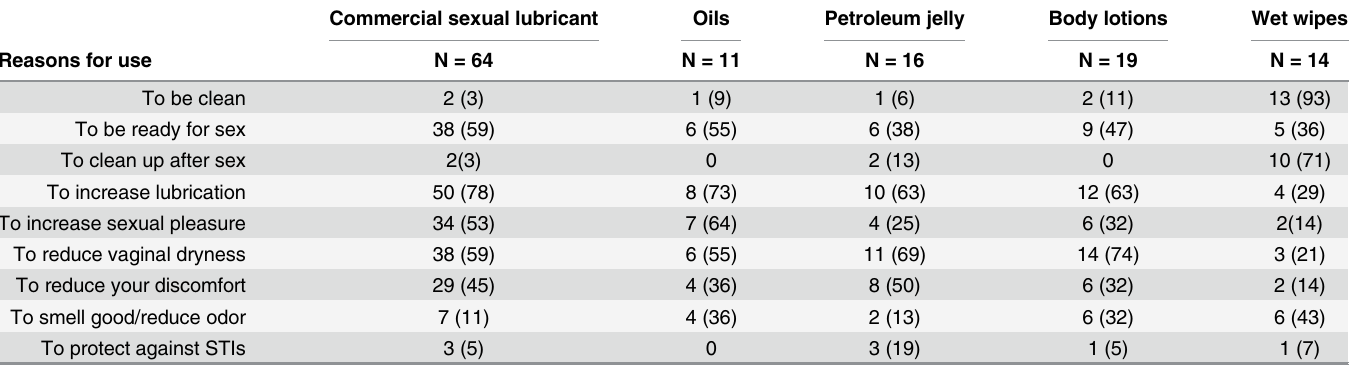
Table 4. Motivations for intravaginal insertion of products during last vaginal intercourse, by type of product